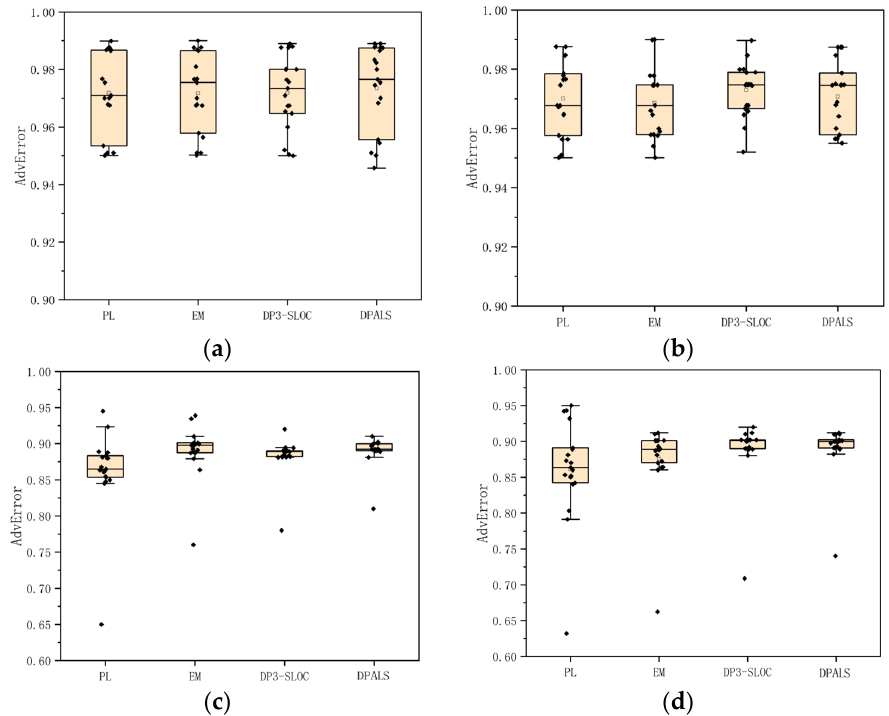
Figure 5. Query error rate of interest points for each region on the two datasets. ( a ) Gowalla Dataset (Paris); ( b ) Brightkite Dataset (Paris); ( c ) Gowalla Dataset (Nanterre); ( d ) Brightcity Dataset (Nanterre).